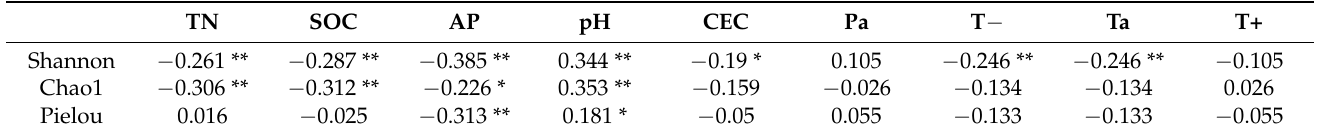
Table 3. Spearman correlation coefficients for bacterial diversity and environmental variables